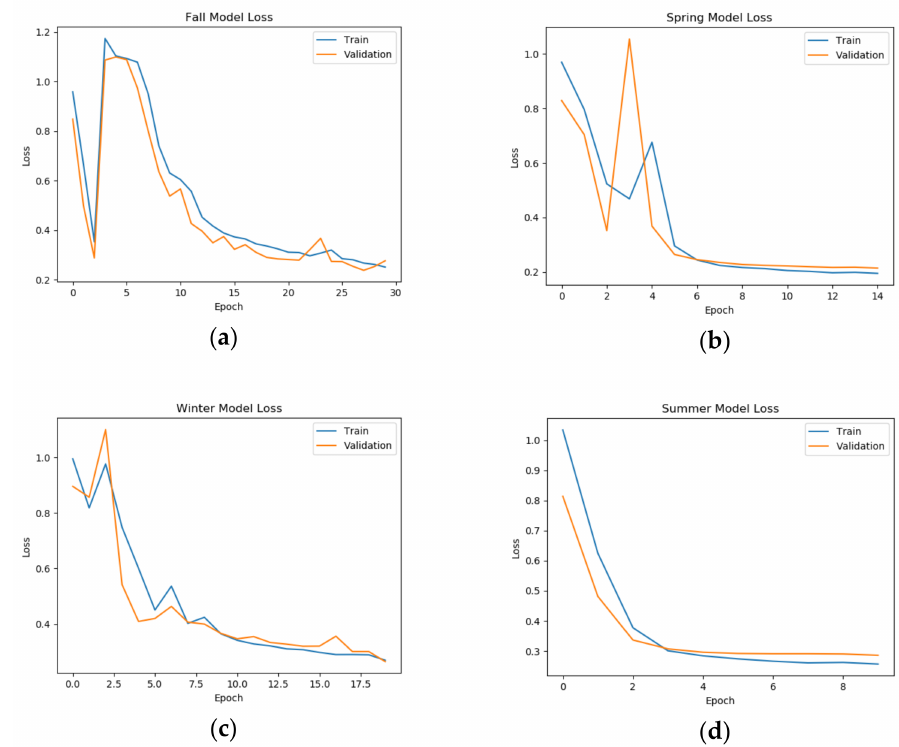
Figure 5. CNN models’ training and validation loss: ( a ) fall model training loss; ( b ) spring model training loss; ( c ) winter model training loss; ( d ) summer model training loss.